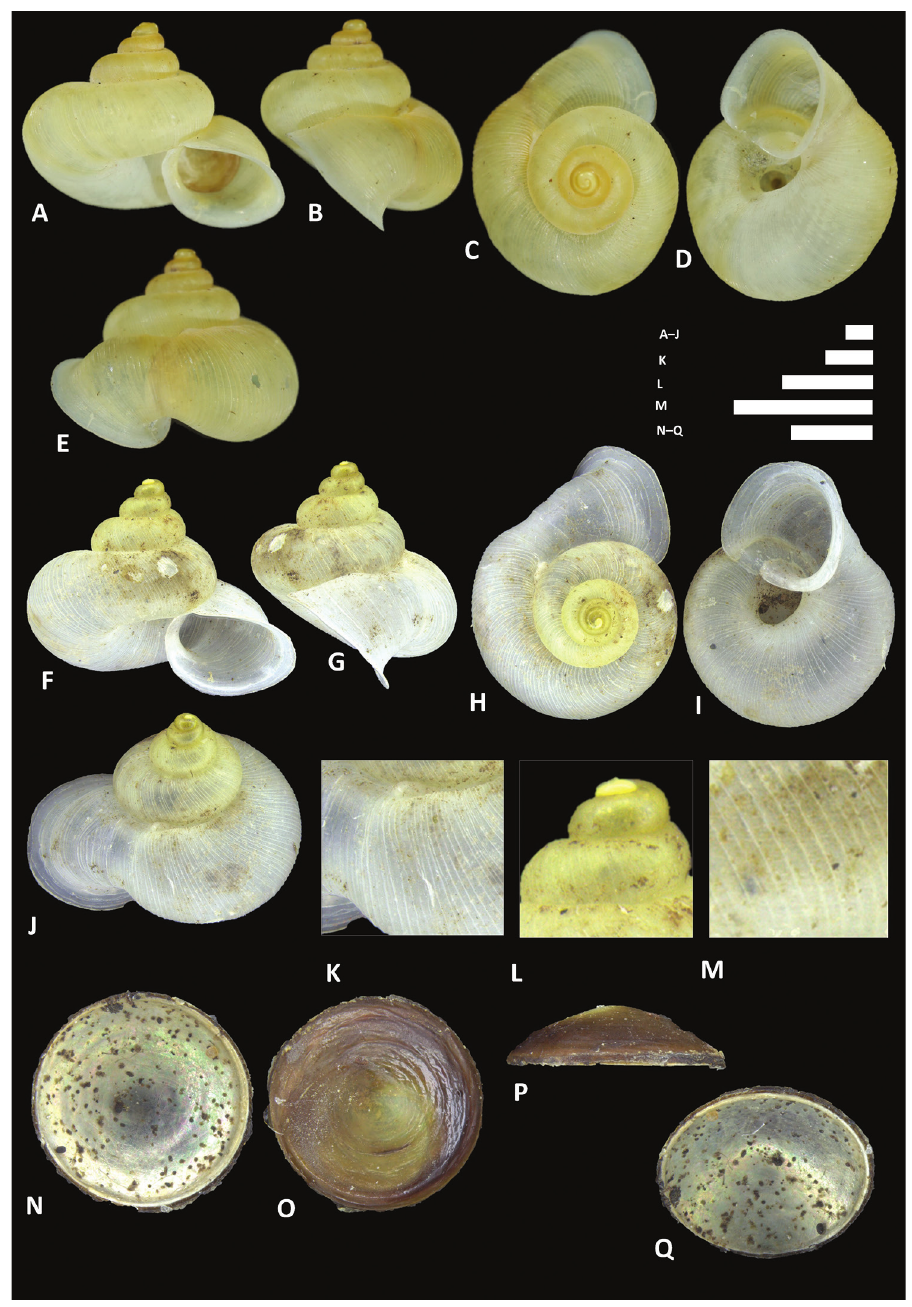
Figure 26. Alycaeus roebeleni Möllendorff, 1894. A–E Shell of syntype, SMF 109317 F–J Shell of BOR/ MOL 8363 K–M Close up of shell of BOR/MOL 8363 N–Q Operculum of BOR/MOL 8363. Scale bars: A–J, K, L, M, N–Q 1 mm. Photographs A–E by Páll-Gergely Barna, courtesy of R. Janssen, SMF. Photographs F–Q by Junn Kitt